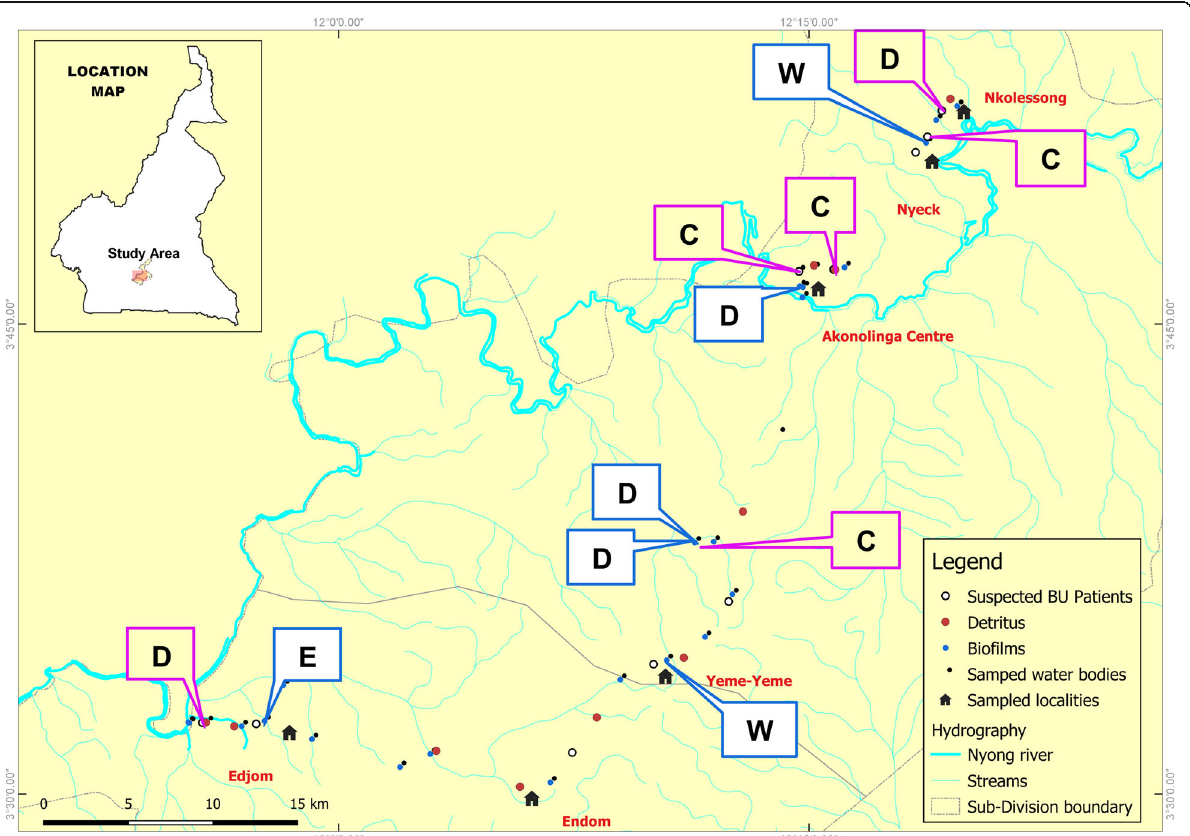
Fig. 2 Community-based geographical distribution of M. ulcerans genotypes from the environment and humans. Blue square callouts contain genotypes found only in the environment (water bodies and biofilms); Pink square callouts have genotypes found only in human beings; Genotype E corresponds to M . marinum ; Genotype D overlaps between the environment and human populations; blue lines represent water bodies (streams and rivers); Sampled water bodies, biofilms, detritus, and suspected BU patients are represented by colored dots as defined in the legend